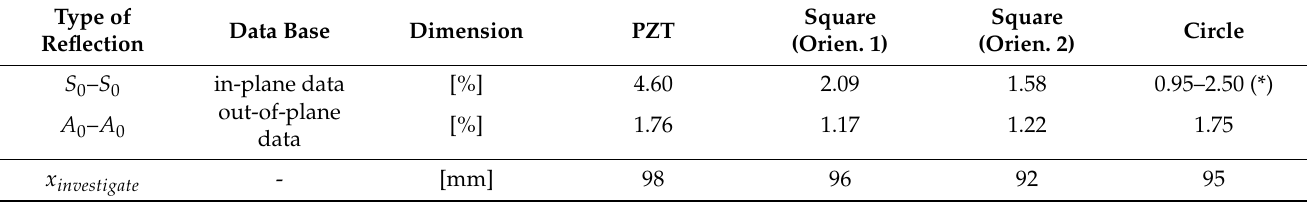
Table 3. Experimentally determined reflections at applied sensors at f c = 300kHz at a distance of 5cm to the respective sensors. Percentage value of ratio between incident and reflected wave package amplitudes.